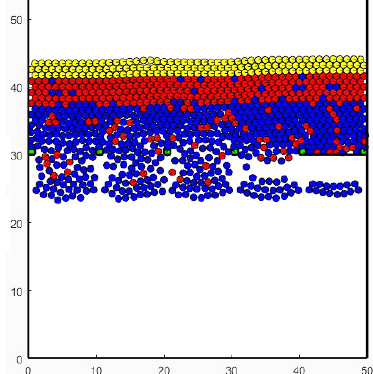
Figure 1. Top-coal caving 2D simulation based on DEM. This is our early work developed by Matlab [51]. The particles in blue, red, and yellow are coal, immediate roof, and basic roof, respectively. In this simulation platform, the controller gets the states of the system, and then calculates the optimal decision of windows’ action by the design algorithm. The source code can be accessed at: “https://github.com/YangYi-HPU/Reinforcement-learning-simulation-environment-for-top-coal- caving” (for non-commercial uses